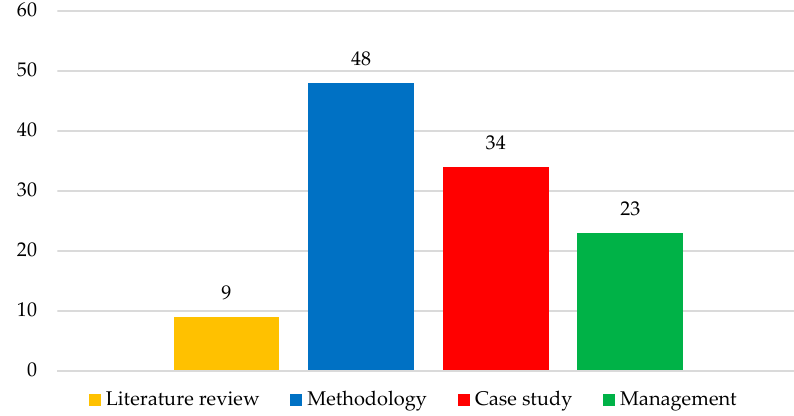
Figure 4. Distribution of the environmental and refurbishment documents by type of publication.